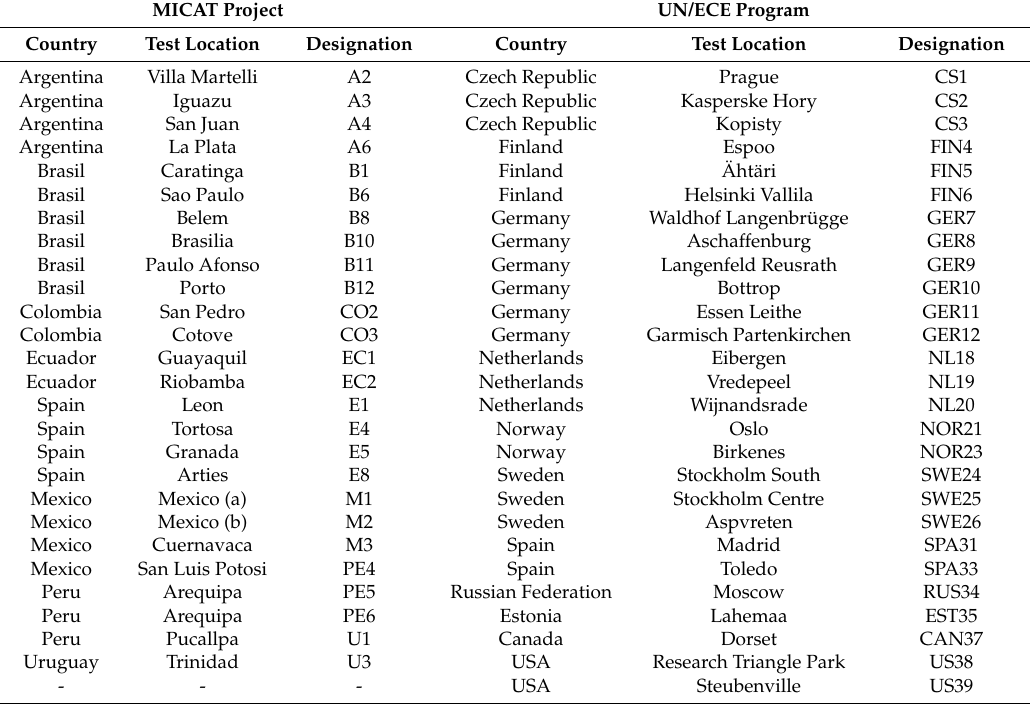
Table 1. Countries, names, and codes of test locations.